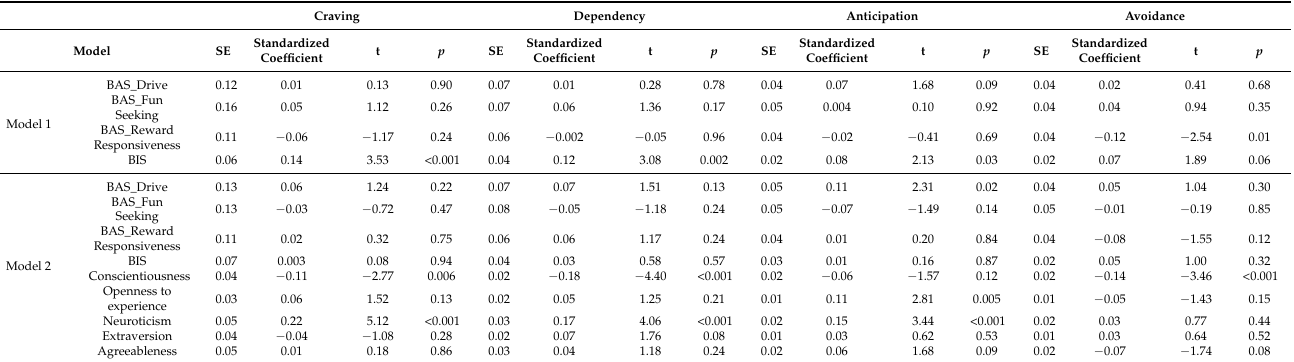
Table 3. Hierarchical linear regression on BWAQ